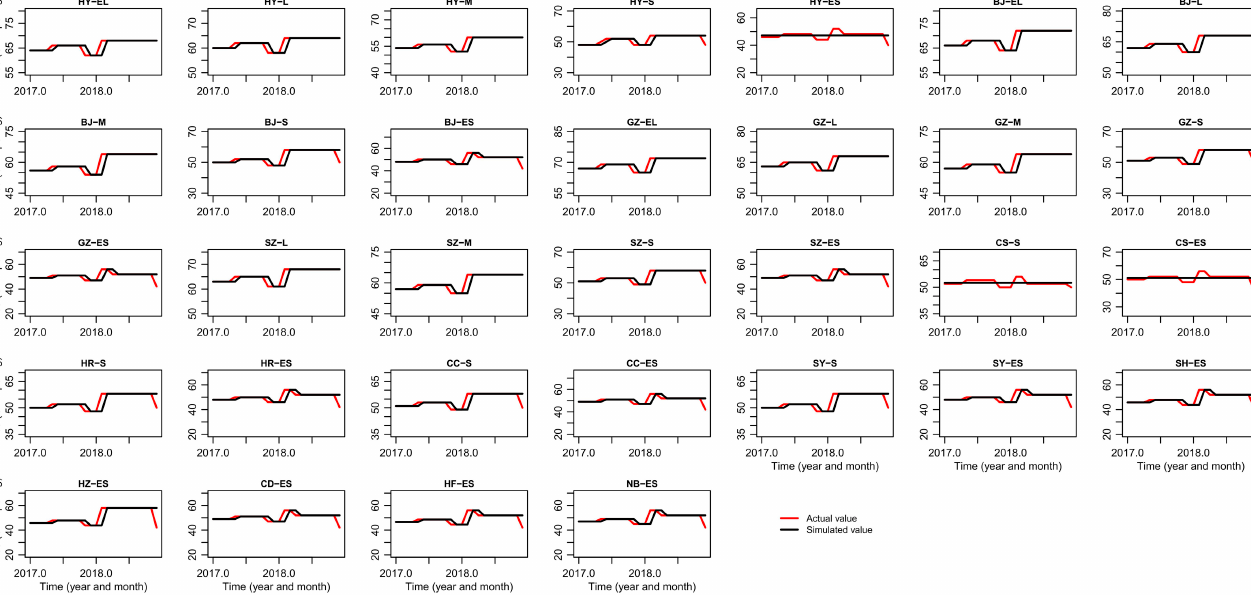
Figure 7. The actual value and simulated value of each specification price in the HY group.